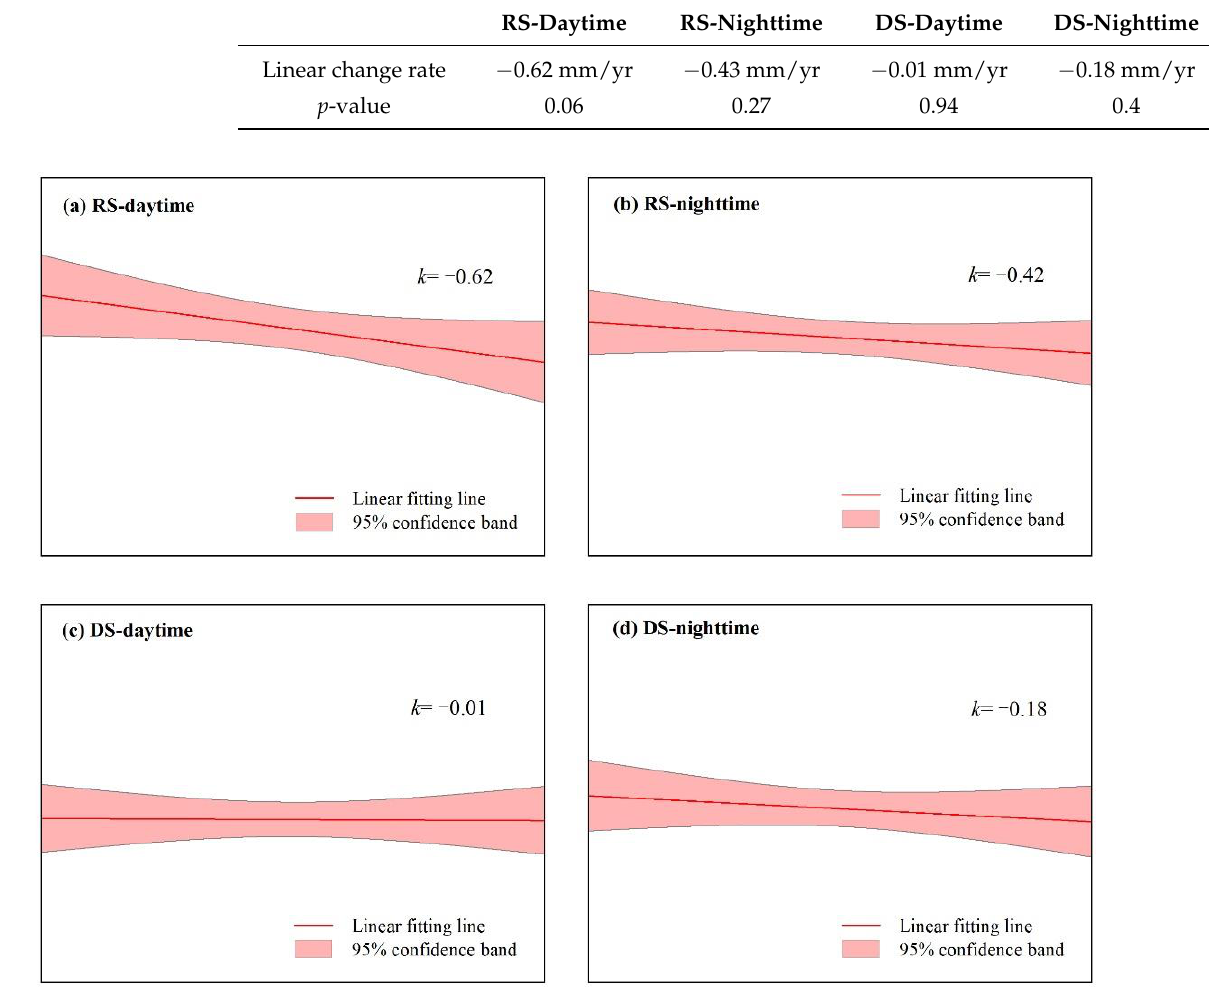
Figure 3. Linear trend of diurnal precipitation in rainy and dry seasons. k represents the linear change rate. Table 1. The change trend of daytime and night-time precipitation in rainy season and dry season.